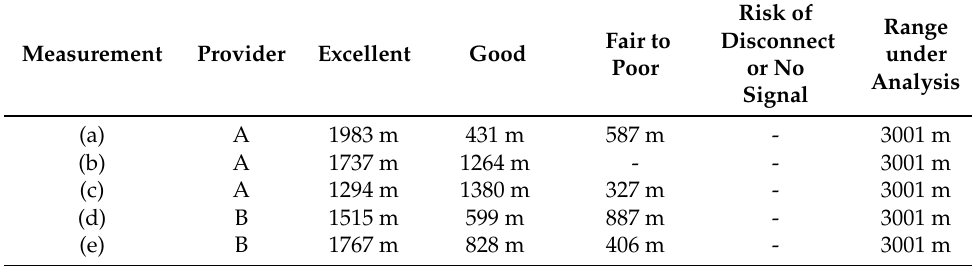
Table 8. Provider-based assessment RSSI.